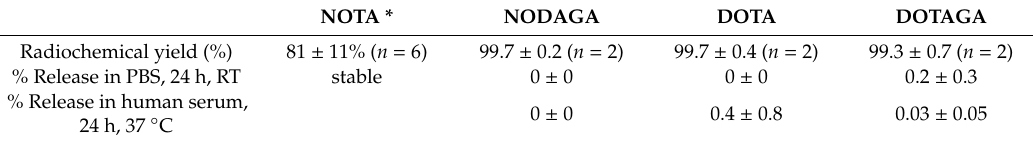
Table 1. Labeling and stability of [ 57 Co]Co-(HE) 3 -Z HER3 -X. NOTA * NODAGA DOTA DOTAGA Radiochemical yield (%) 81 ± 11% ( n = 6) 99.7 ± 0.2 ( n = 2) 99.7 ± 0.4 ( n = 2) 99.3 ± 0.7 ( n = 2) % Release in PBS, 24 h, RT stable 0 ± 0 0 ± 0 0.2 ± 0.3 % Release in human serum, 24 h, 37 °C 0 ± 0 0.4 ± 0.8 0.03 ± 0.05